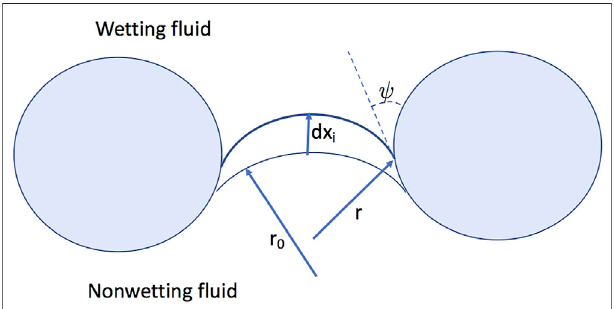
FIGURE 2 | The fi gure illustrates a nonwetting fl uid invading a wetting fl uidatasinglepore-throatatdifferentradiusofcurvature r distance moved between the two front positions is dx i and ψ is the wetting angle.